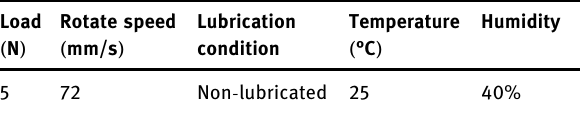
Table 3: Experimental parameters of HT - 2001 POD pin disc wear tester Load Rotate speed ( N ) ( mm/s )